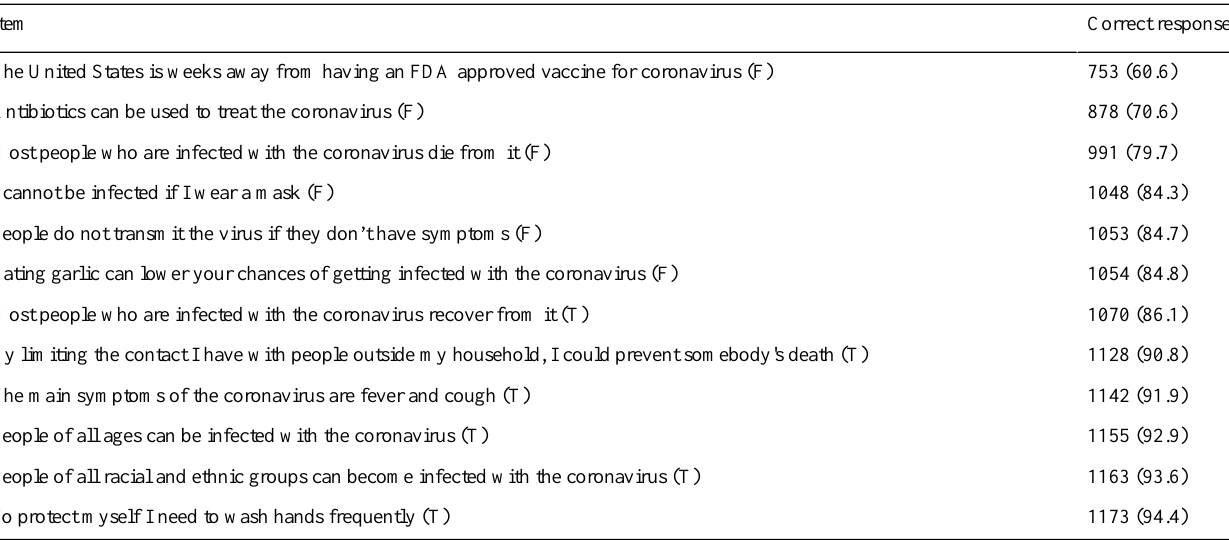
Using correlations, we found a positive association between knowledge and trust in government sources such as the CDC, the FDA, local health departments, and the WHO (Table